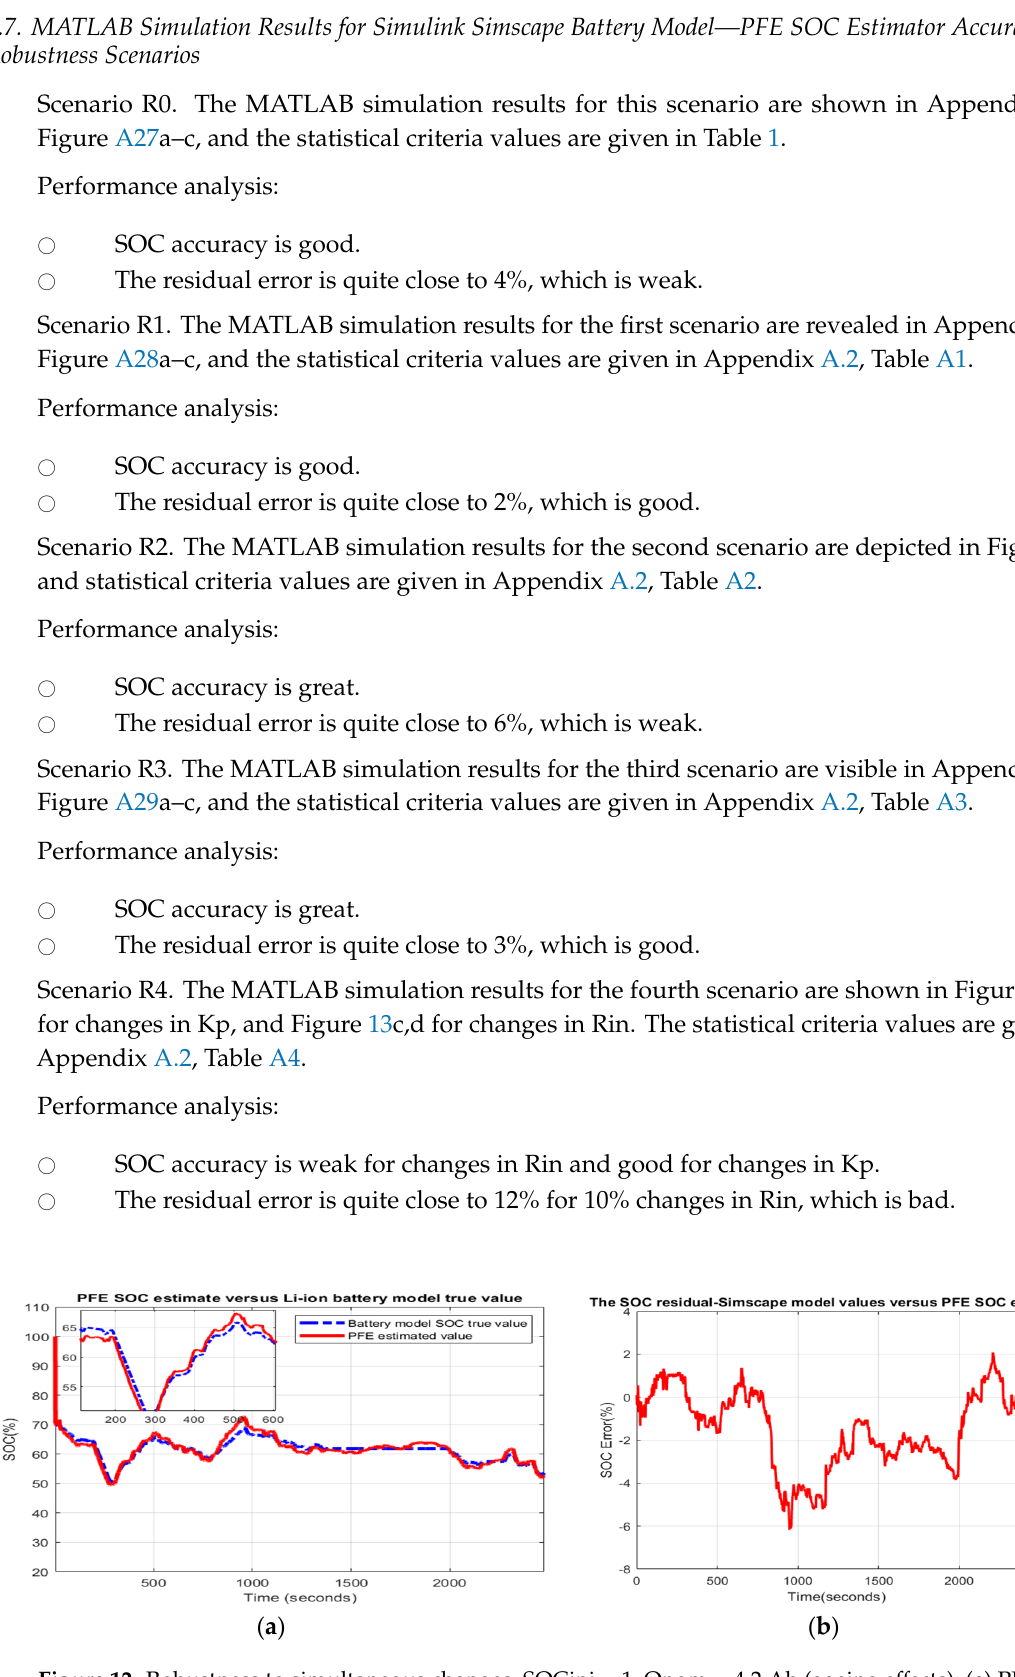
Figure 12. Robustness to simultaneous changes, SOCini = 1, Qnom = 4.2 Ah (ageing effects); ( a ) PFE SOC value versus battery model true value; ( b ) SOC residual.